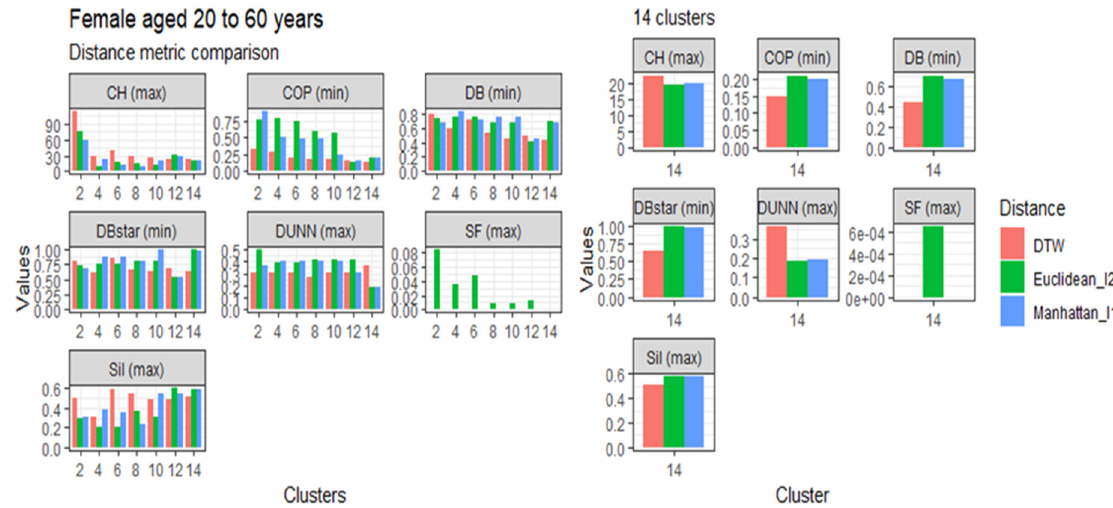
Figure 3. Model comparison of the DTW, Euclidean (l1), and Manhattan (l2) distance criteria for females aged 20 to 60.